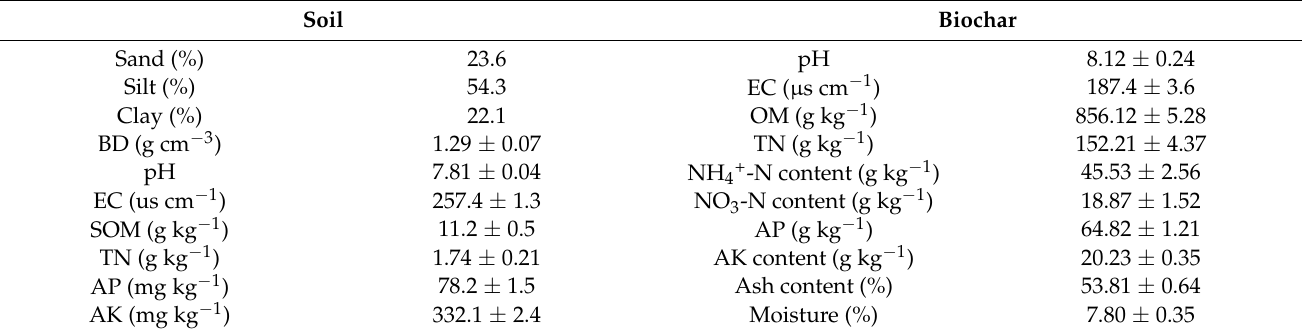
Table 1. Basic physio-chemical properties of soil and biochar used in the present study. Soil